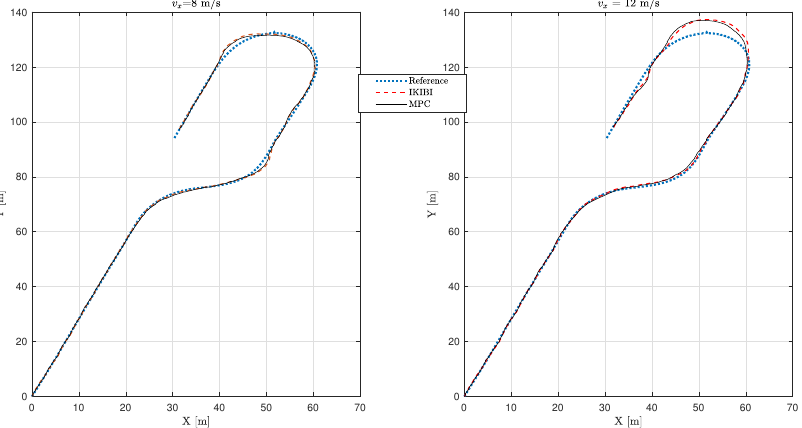
Figure 8. Vehicle path: slow sensor feedback test with noise using the DREKF. ( left ) v x = 8 m/s ( right ) v x = 12